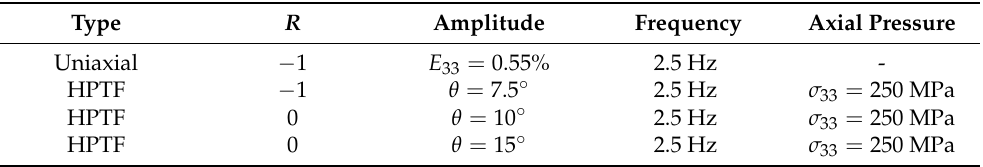
Table 2. Details of uniaxial fatigue and high pressure torsion fatigue (HPTF) experiments. Axial stress and strain components are denoted by indices “33”.